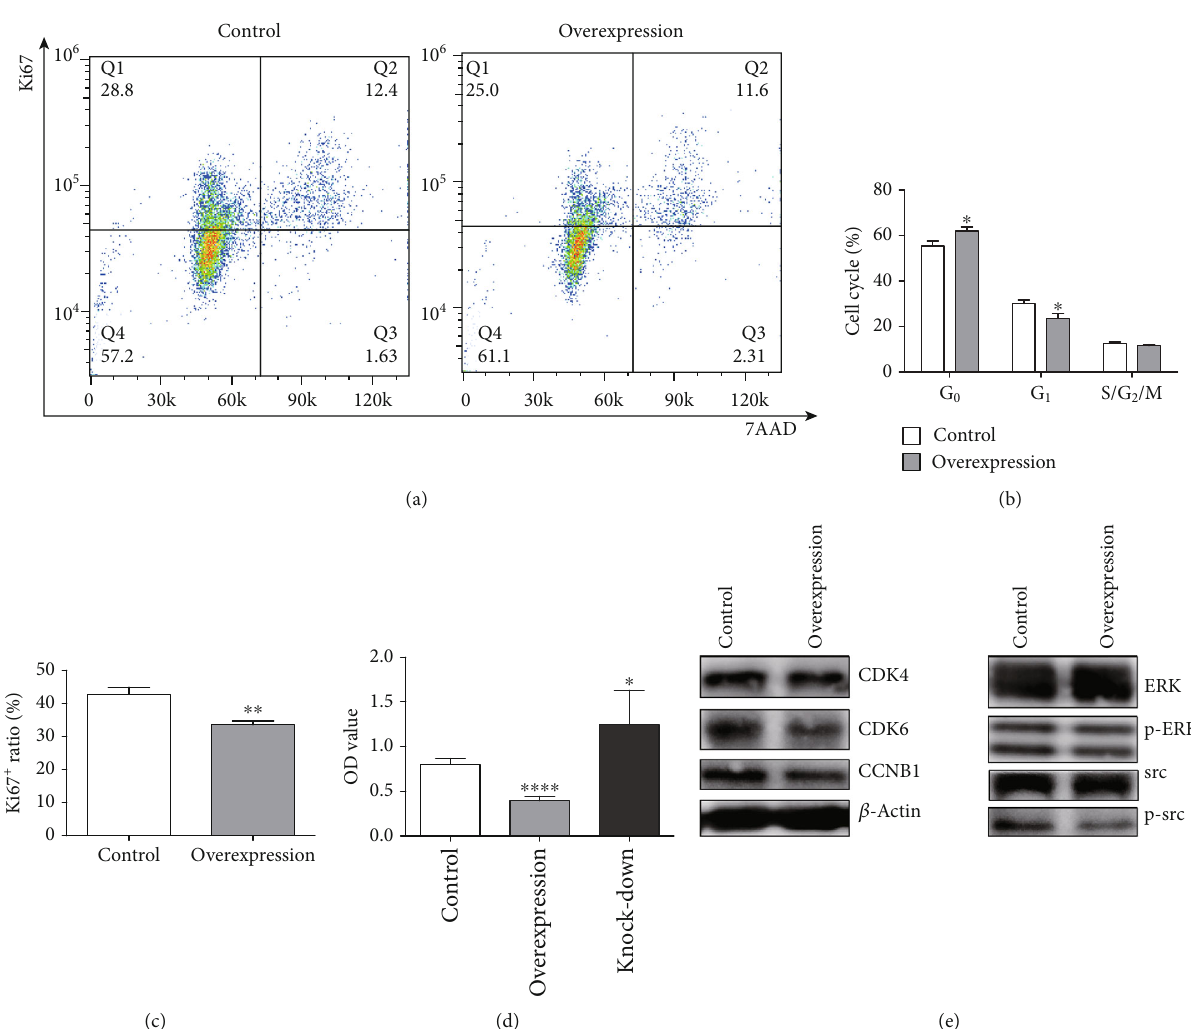
Figure 3: Cellular proliferation and cell cycle in BM-MSCs. (a – c) Typical fl ow cytometric results of cell cycle and proliferation analysis in the di ff erent groups of BM-MSCs. (a) The quadrant with Ki67 − 7AAD − represents the G phase, Ki67 + 7AAD − represents the G phase, and 0 1 /M phase. (d) Statistical analysis of the OD values of three di ff erent groups of BM-MSCs from the CCK8 Ki67 + 7AAD + represents the S/G 2 assay. (e) Western blot analysis of some proliferation and cell cycle-associated molecules in BM-MSC control and overexpression groups. All experiments were repeated at least three times. Data are presented as mean ± SD . ∗ p < 0 : 05 , ∗∗ p < 0 : 01 , and ∗∗∗ p < 0 : 001 . ns: no signi fi